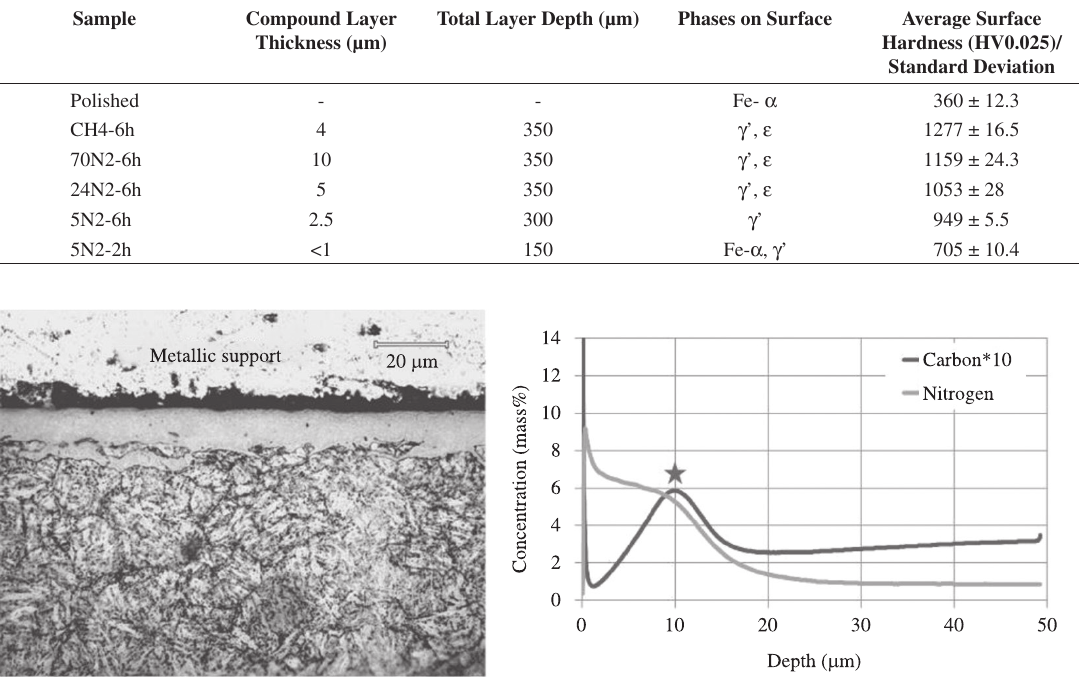
Table 3. Summary of obtained